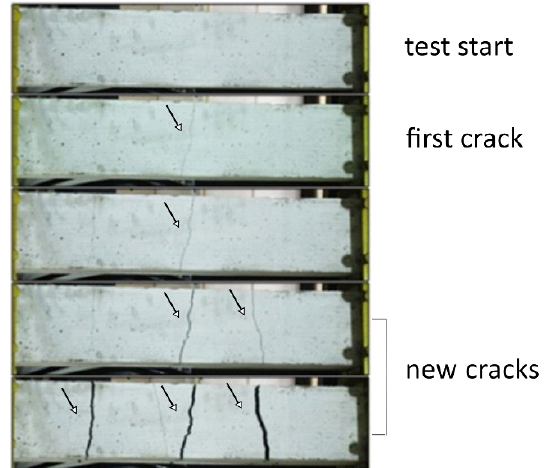
Figure 14. Evolution of the cracking during the tension stiffening test of